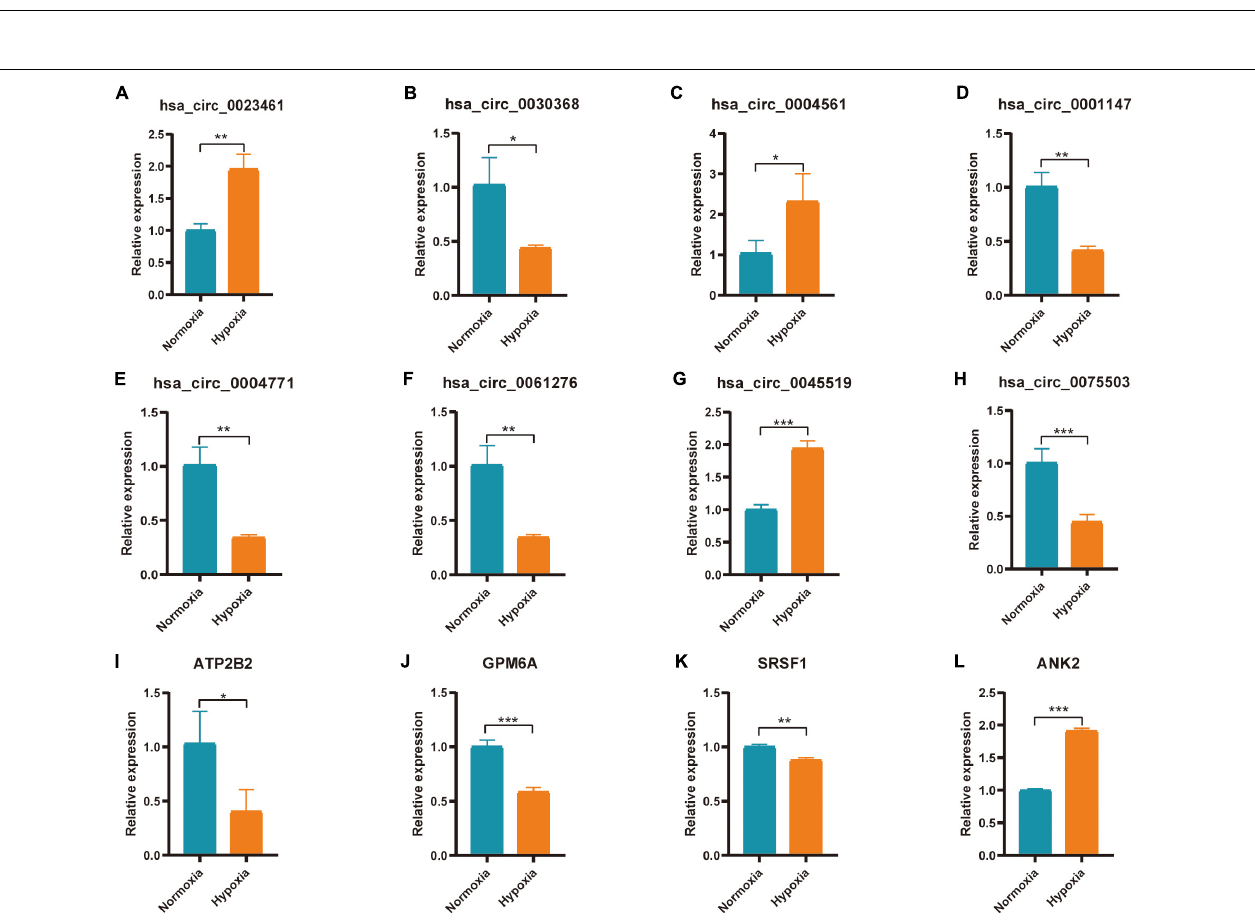
FIGURE 9 | Expression of Hub gene and Hub gene related circRNAs in AC16 cell hypoxia model. For panels (A–L) * P < 0.05; ** P < 0.01; *** P < 0.001.